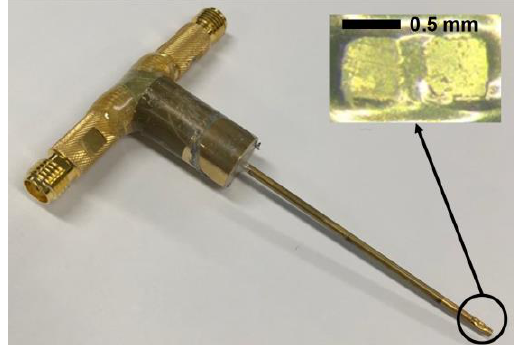
Figure 6. Photograph of the fabricated dual-element focused transducer for intravascular ultrasound tissue imaging using the third harmonic.